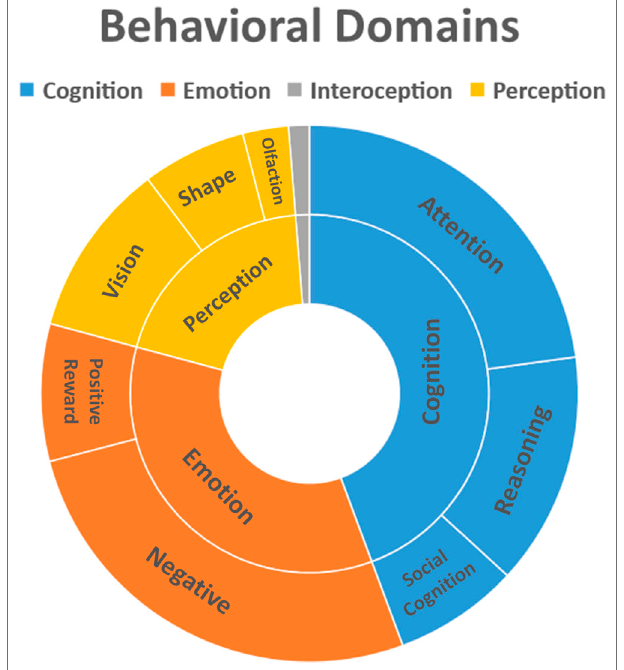
FIGURE 3 | Behavioral domains affected by use of psychoactive substances. Behavioral data was extracted from Mango plugin (Behavioral Analysis Plugin v3.1) for the clusters obtained from the quantitative ALE analysis (Z-score >